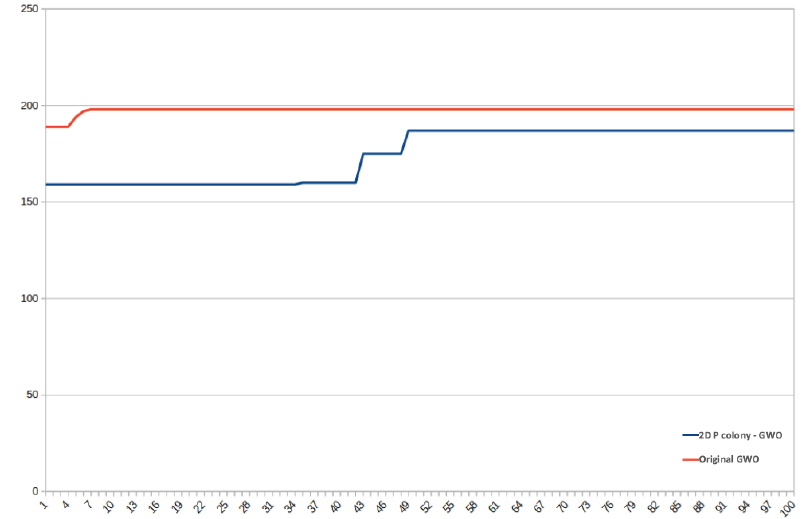
Figure A1. Results of testing function F 1 .